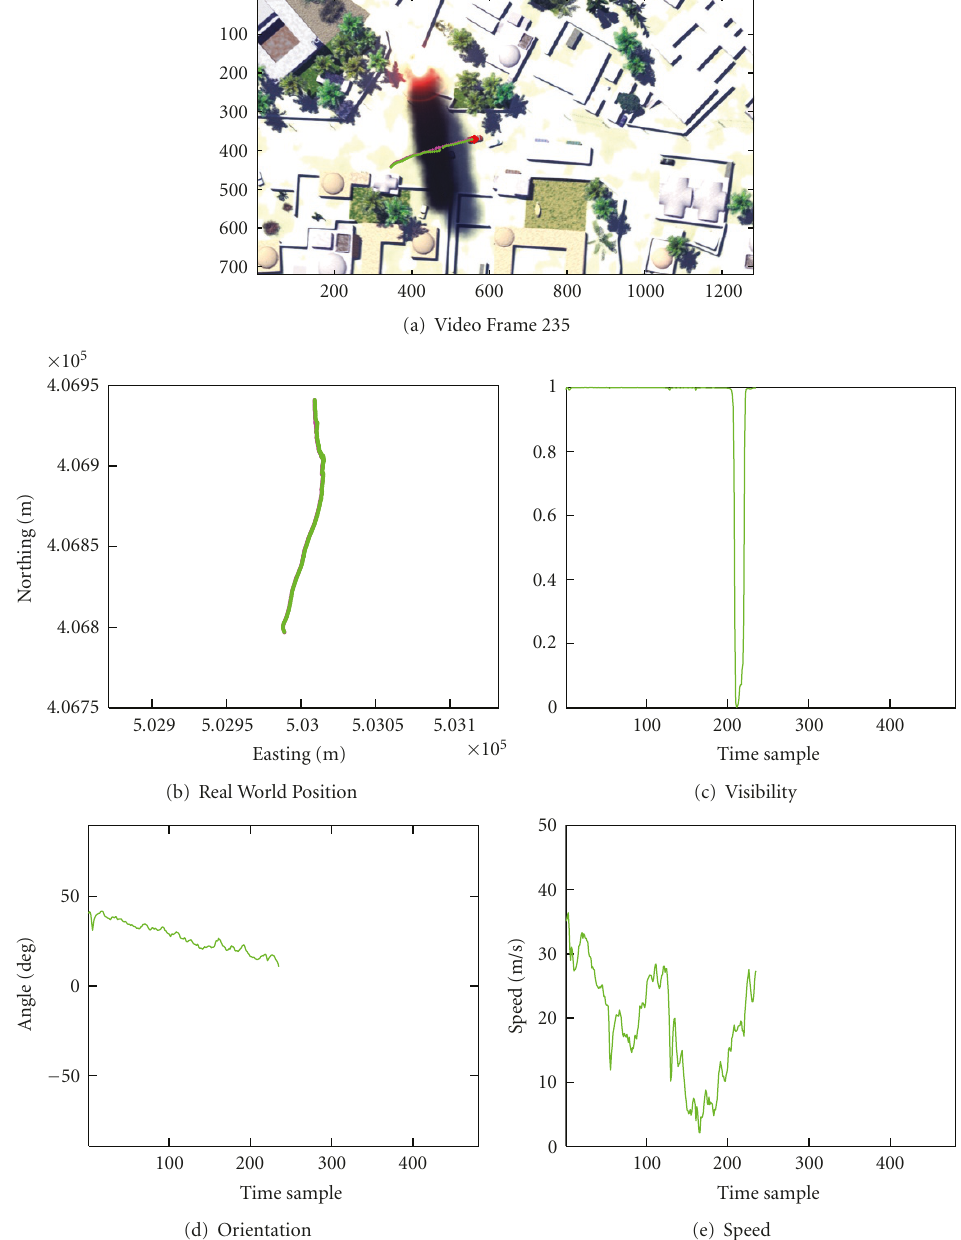
Figure 6: Tracking results at video frame 235. This shows the vehicle emerging from a full occlusion due to thick smoke. (a) shows the RBPF MAP estimate of the vehicle’s position (plotted in green for video frame from 175 to 235 projected onto the current video frame) and the posterior particle distribution of the position of the vehicle in the video frame (in red). The magenta track shows the true vehicle track projected onto the current video frame. It can be seen that the RBPF MAP estimate of the vehicle’s position in the image plane is very close to the true vehicle’s position. (b) shows a plot of the RBPF MAP estimate of the real world position (in green) of the vehicle from video frame 1 to 235. The magenta track shows the corresponding true vehicle track in the real world. (c), (d), and (e) show the estimated visibility, speed, and orientation of the vehicle, respectively. (c) shows clearly the decrease and subsequent increase in visibility as the vehicle enters and emerges from the smoke